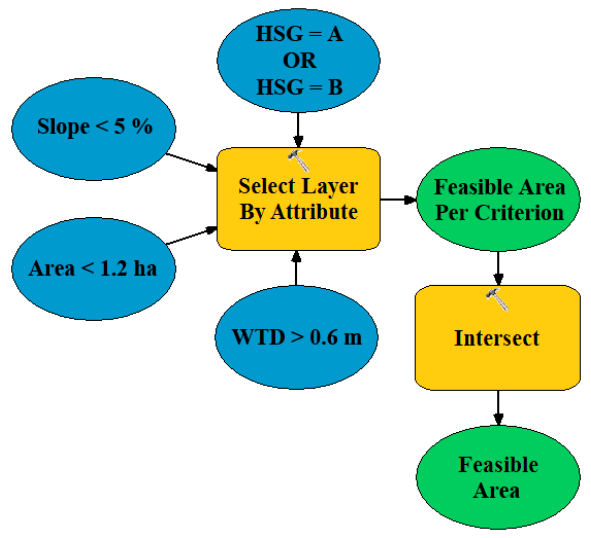
Figure 1. Workflow for the identification of feasible areas for the implementation of Permeable Pavement Systems (PPS).